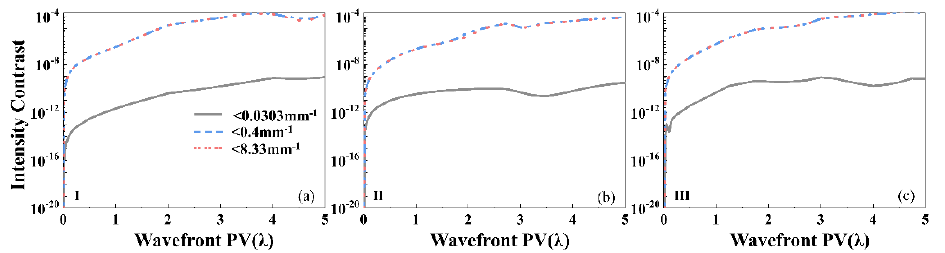
Figure 10. Variation in the relative intensity of focal sidelobes with PV value under different spatial